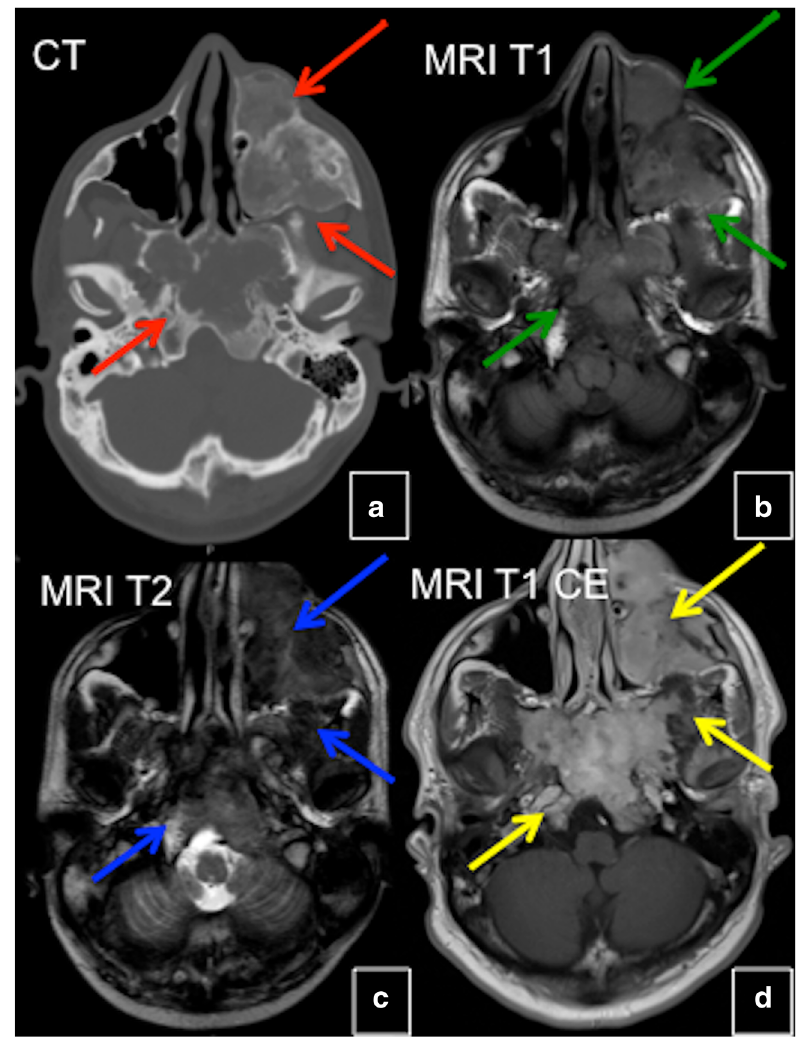
Fig. 8 CT and MRI in craniofacial fibrous dysplasia (FD). a CT demonstrates mixed sclerotic FD lesions involving the skull base ( red arrows ). b Lesions demonstrate intermediate signal intensity on T1 weighted MRI ( green arrows ). On T2 weighted images lesions demonstrate heterogeneous hypointense/ intermediate signal intensity ( blue arrows ). d FD lesions show slightly heterogeneous enhancement ( yellow arrows )